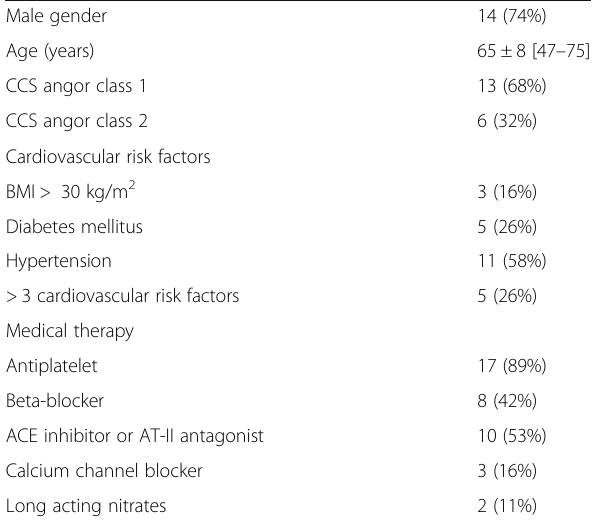
Table 1 Characteristics of the study